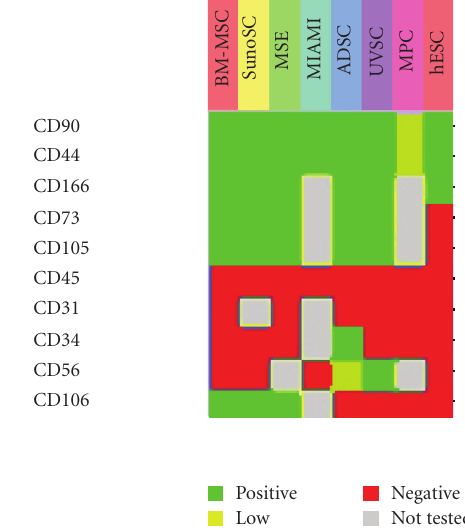
Figure 2: Expression of cell surface markers of MSCs. Hierarchical clustering of the expression of cell surface markers of MSCs from di ff erent MSCs preparations. Cells were termed “mesenchymal stem cells (MSCs)” [11], “mesodermal progenitor cells (MPCs)” [12], “marrow-isolated adult multilineage inducible (MIAMI) cells” [13], and “bone marrow-isolated mesenchymal stem cells (BM-MSCs),” “adipose tissue-isolated stem cells (ADSCs),” “synovia-derived stem cells (SynoSCs),” “umbilical vein stem cells (UVSCs),” and “human embryonic stem cells (hESCs)” [14]. The figure shows the di ff erent cell preparations in columns and the surface antigens in rows. The green color codes for positive expression, yellow codes for low expression, red codes for no expression, and grey color stands for not determined in the respective experiments. It is seen that the cells can be defined by the presence and absence of a distinct pattern of cell surface markers, that is, CD34( − ), CD45( − ), CD117( − ) (cKit), CD44(+), CD90(+), and